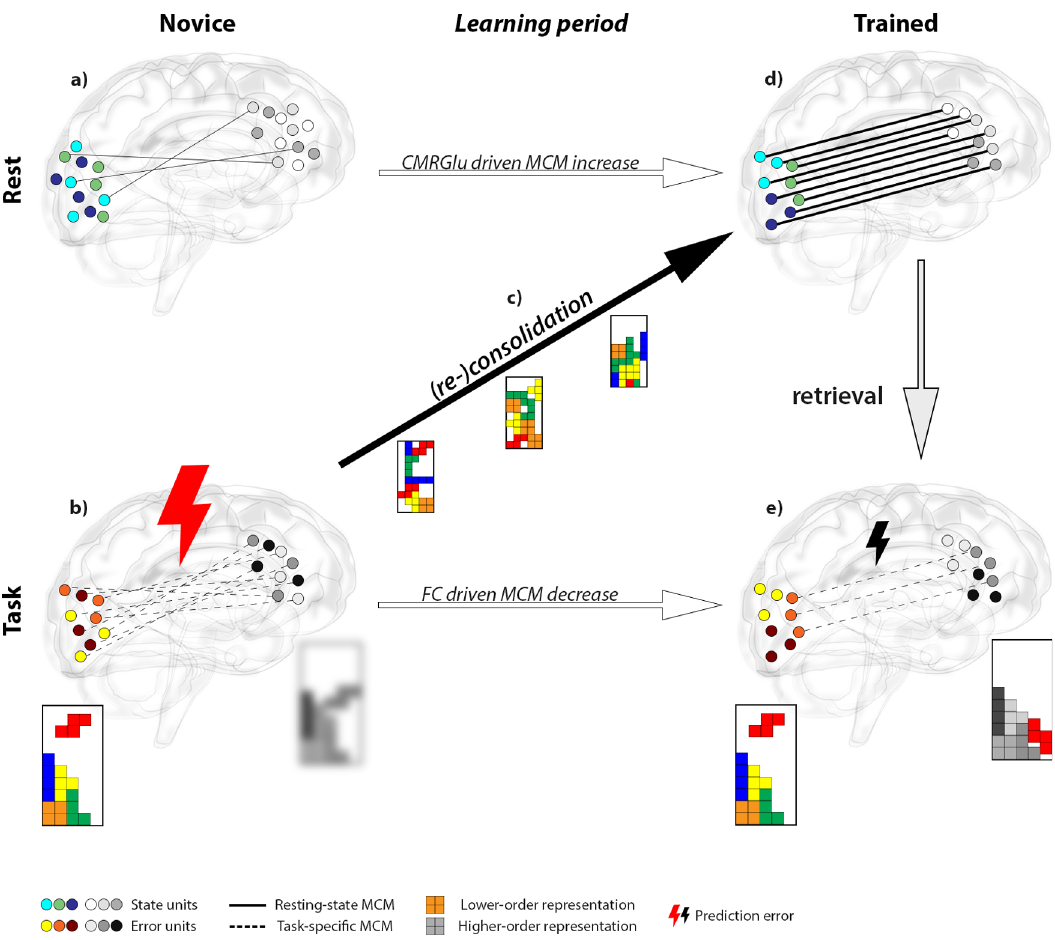
Fig. 6 Schematic illustration of training effects and potential neurobiological mechanisms. Cognitive skill learning results in complementary metabolic adaptations at rest (top row) and functional network reorganization during task execution (bottom row). Glass brains depict directional connectivity from the higher-order salience network (grayscale circles) to the lower-order occipital region (colored circles) as assessed with metabolic connectivity mapping (MCM, number of lines). a Training naïve subjects exhibit low directional connectivity at resting-state (solid lines) between unorganized state units (blue- green circles), since the skill trace is not yet established (random circle arrangement, crossing lines). b Due to the lack of training, higher-order representations in the SN are inaccurate (blurred grayscale Tetris ® ) in comparison to lower-order visual sensory information (colored Tetris ® ), resulting in a high prediction error (large thunderbolt) encoded by error units (red – yellow circles). The representational inaccuracy requires substantial dynamic optimization between brain regions of different hierarchies (numerous dashed lines). c With repeated task performance during the learning period functional network reorganization approaches an optimal solution. Presumably, this is realized by a high frequency of synaptic tagging, where optimal task representations are gradually encoded in the salience network by synaptic capture and subsequent anchoring of glutamatergic AMPA receptors. d After the learning period, state unit directional connectivity increases, which equals the consolidated skill engram (parallel lines between organized circles). The metabolic emphasis of this process suggests the energy-intensive formation of clustered and potentiated synapses (line thickness). e The established skill engram can then be retrieved for task execution. This results in a decreased prediction error (small thunderbolt) as representations between higher- and lower-order brain regions became more accurate (sharpened grayscale Tetris ® ). Thus, only minor cognitive control is required (few dashed lines) to apply an ef fi cient task strategy. In sum, these observations indicate that effects of skill learning at resting-state and during task execution are two sides of the same coin, where different neurobiological mechanisms complement each other to improve task performance. The glass brain was kindly provided by Dr. Gill Brown (https://neuroscience-graphicdesign.com/) under CC BY-NC phase between the two PET/MRI scans participants were instructed to train on a requires speci fi c training. We therefore expected the most pronounced effects regular basis (45 – 60min per session, at least 20 sessions within 4 weeks). An regarding behavioral data and neuroplasticity for the hard task condition. In this individual username and password were provided to access the web-based training task bricks of different shapes drop from the top of the screen. By rotation and platform in the web browser Chrome. Subjects were able to select any combination alignment of the bricks, the aim is to build complete horizontal lines which dis- of brick speed and prebuilt lines freely. However, the explicit aim of the 4-week appear and increase the score. Bricks were moved by operating four buttons with training period was to be able to manage the hard task condition as carried out in the right hand only (index fi nger: move brick left, middle: rotation, ring: down, the PET/MRI session. The implemented scoring was identical for the PET/MRI small: right; same fi xed assignment for in-scanner and online version). measurements and online training, following the original scheme of Tetris ® . The For the PET/MRI measurements, the two levels of dif fi culty differed regarding score for each complete line was k * (n + 1), with n being the speed level of the the speed of the falling bricks (easy/hard: 1/3 lines per sec) and the number of falling bricks and k representing the score for one (40), two (100), three (300), or incomplete lines that were already built at the bottom (easy/hard: 2/6 lines out of four (1200) lines removed simultaneously. 20). An additional control condition was employed for the BOLD block design, At each PET/MRI examination, participants also completed a cognitive testing where bricks were navigated through a chimney and disappeared at the bottom. session outside the scanner to relate improvements in task performance to speci fi c Participants familiarized themselves with the task and control buttons by a 30 s cognitive domains of mental rotation, visual search, and working memory, as well training of each task condition right before the scan started. For the online learning